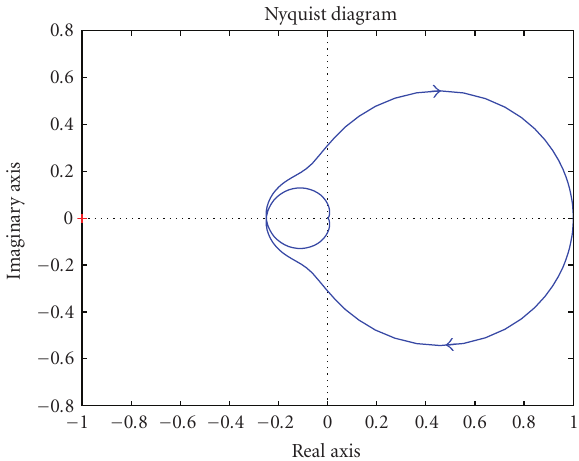
Figure 6: Nyquist plot of the closed loop boost converter.